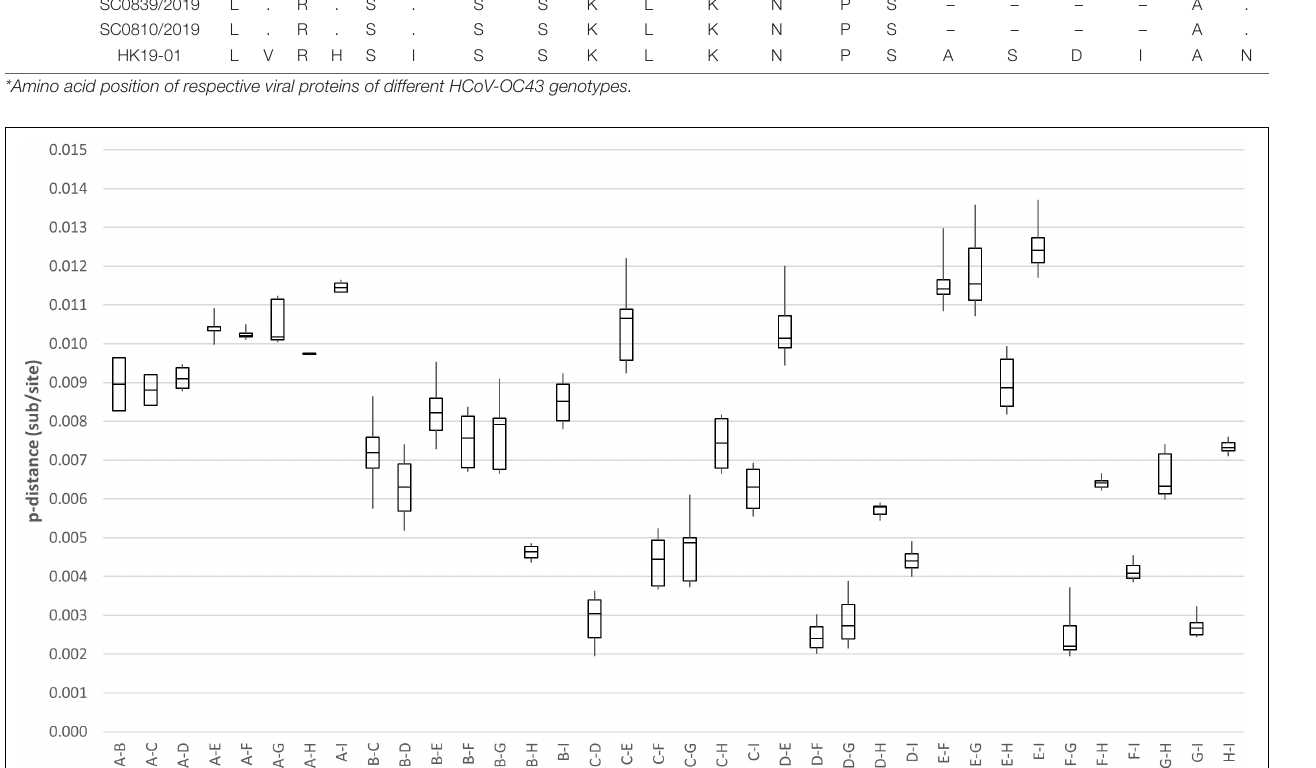
accession numbers MN306041, MN306042, and MN306053), with a bootstrap value of 100% and sharing 99.9% nucleotide identities ( Figure 2